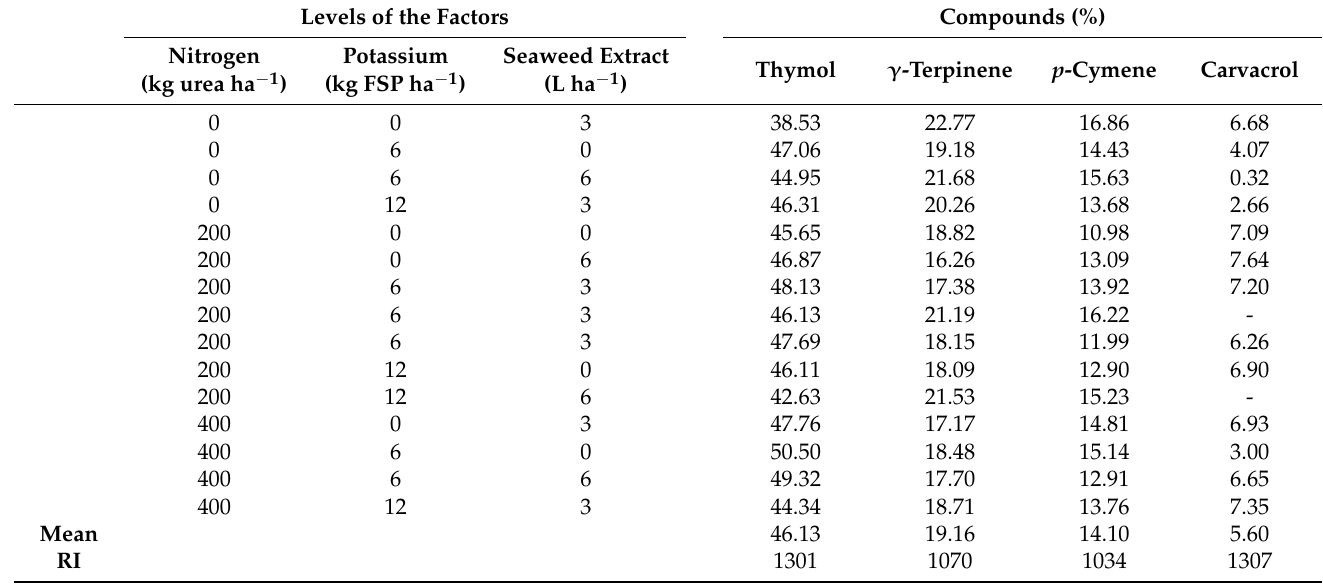
Table 6. The main compounds of thyme essential oil as affected by the experimental factors.